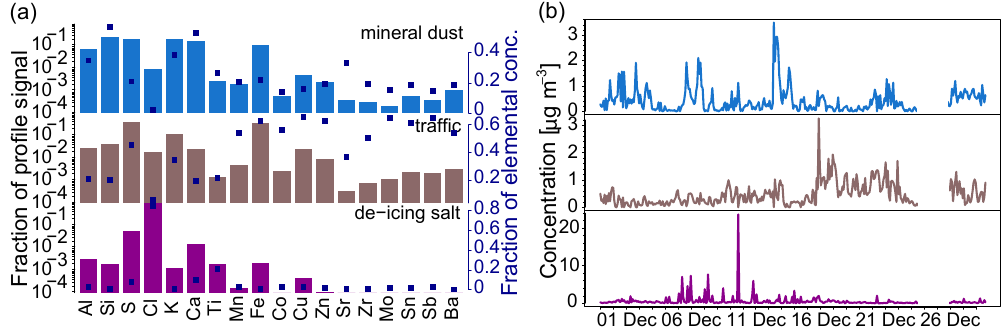
Fig. 5. PMF results for PM 10 − 2 . 5 , (a) factor profiles, from top to bottom: mineral dust, road traffic and de-icing salt. The solid bars (left y -axis) represent the amount of each species apportioned to the factor and the blue squares (right y -axis) represent the fraction of the total of each species, (b) corresponding time